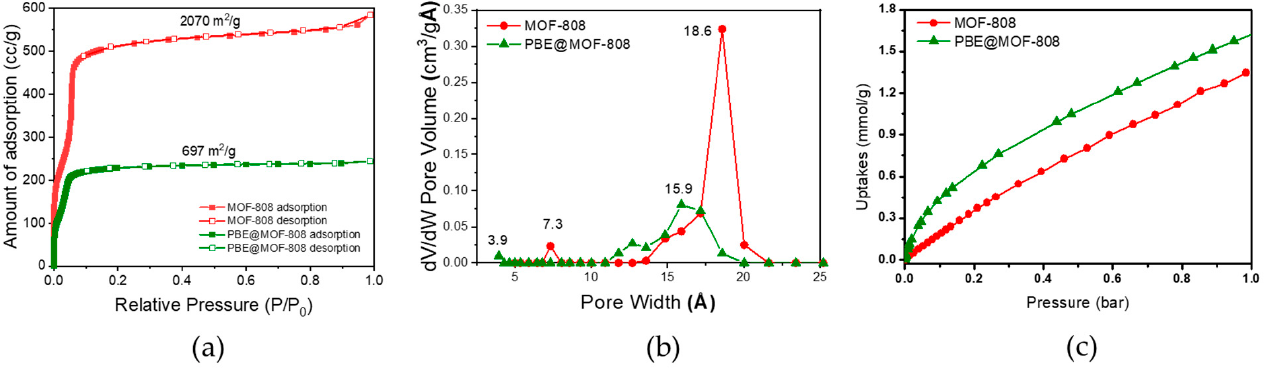
Figure 3. ( a ) BET isotherms. ( b ) pore size distributions. ( c ) CO 2 adsorption isotherm of pristine MOF-808 and washed MOF-808 after being mixed with PBE copolymer (PBE@MOF-808).